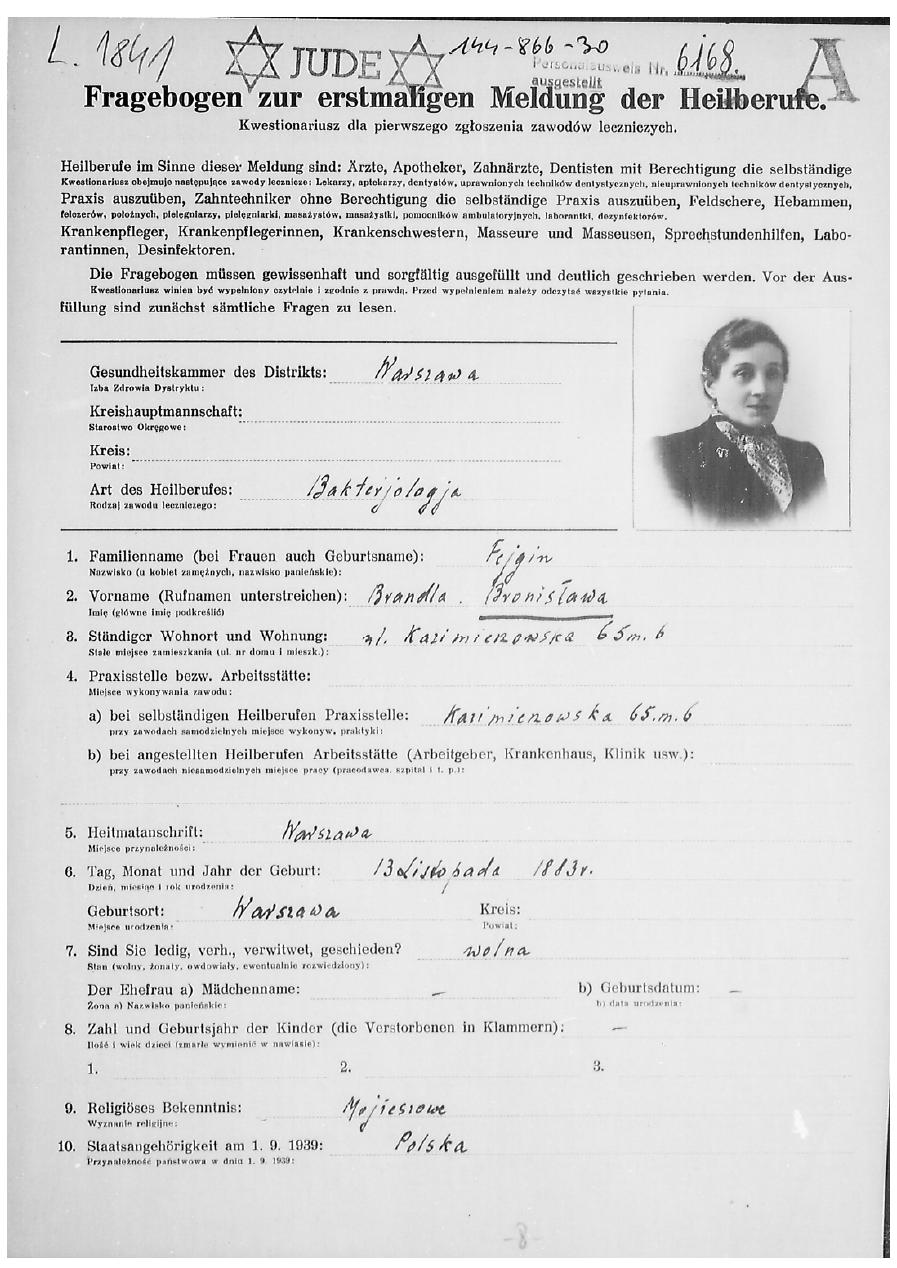
Figure 2. Dr. Bronislawa Fejgin’s Warsaw Ghetto Registration Document. Source: Main Physicians Library, Warsaw, Poland (public domain).